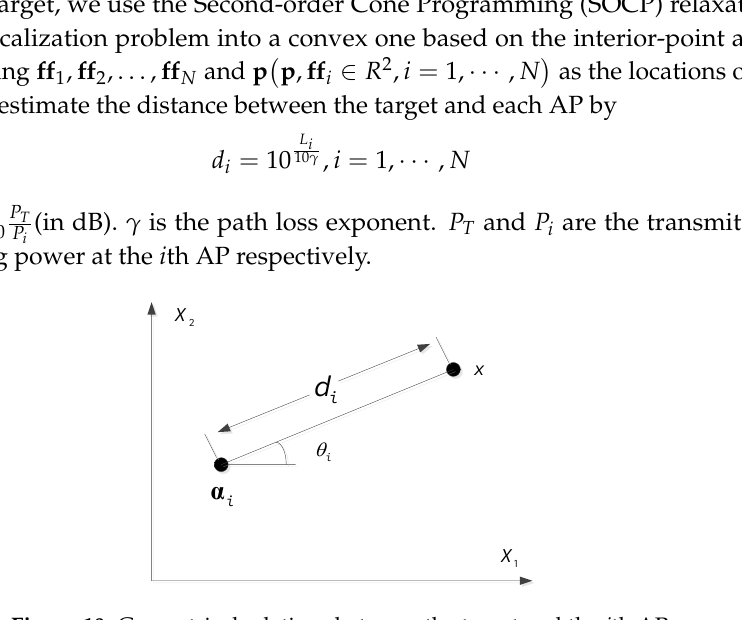
Figure 10. Geometrical relations between the target and the i th